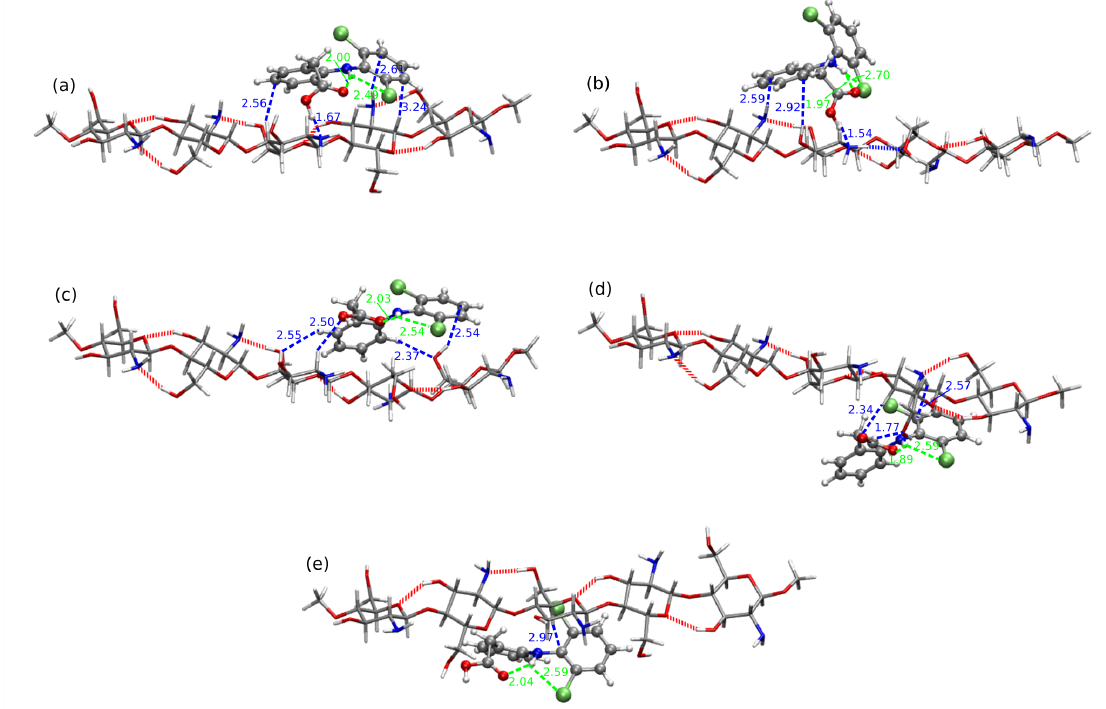
Figure 11. B97-D3/6-311++G(d,p) interaction in most attractive: ( a ) CS5:DFH 1 , ( b ) CS5:DFH 10 , ( c ) CS5:DFH 5 , ( d ) CS5:DFH 9 and the weakest CS5:DFH complexes ( e ) CS5:DFH 8